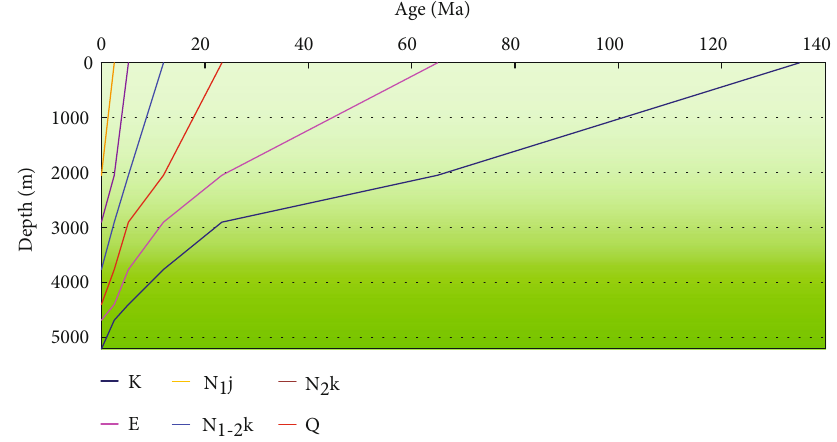
Figure 8: Buried depth of Mesozoic and Cenozoic.